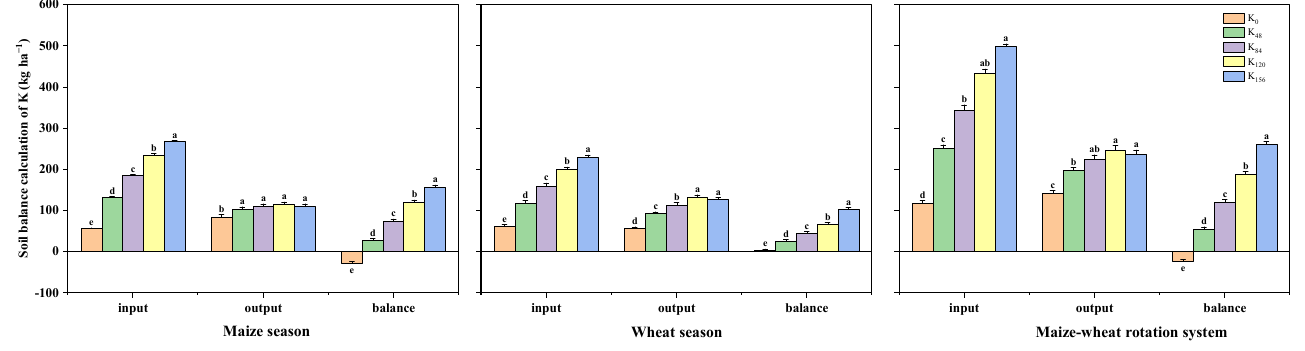
Figure 3. Effects of different K fertilization rates on soil K balance. K 0 , no K fertilizer application; K 48 , 48 kg K ha − 1 ; K 84 , 84 kg K ha − 1 ; K 120 , 120 kg K ha − 1 ; K 156 , 156 kg K ha − 1 . Vertical T bars in the histogram indicate SE. Different letters indicate significant differences among treatments.